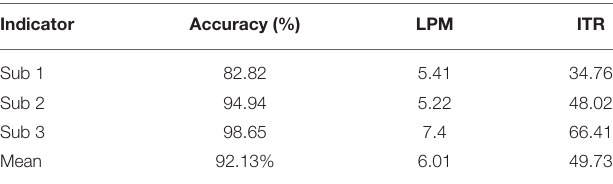
TABLE 3 | The experimental performance of Chinese words spelling for 3 subjects.